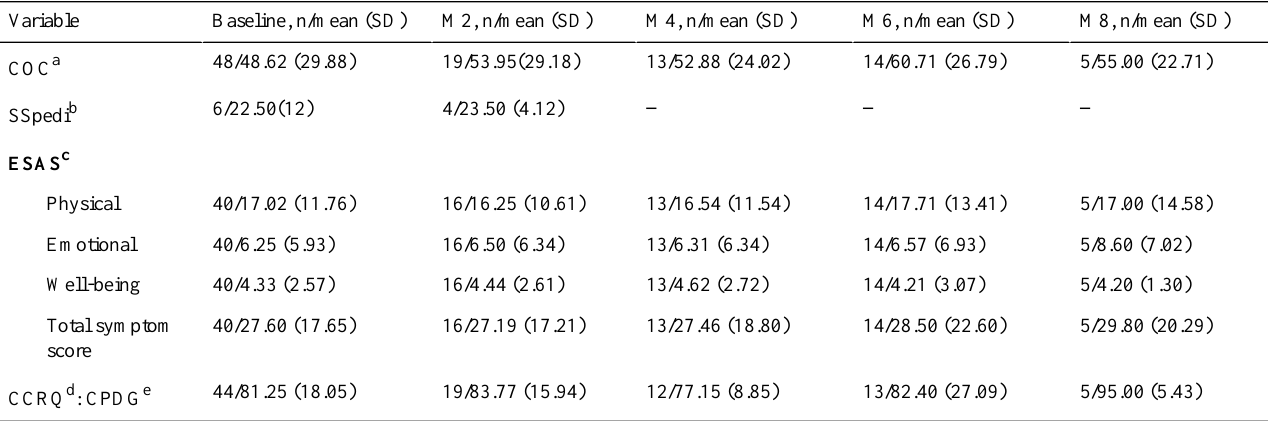
Table 8. Patient Surveys: Summary Descriptive Statistics.